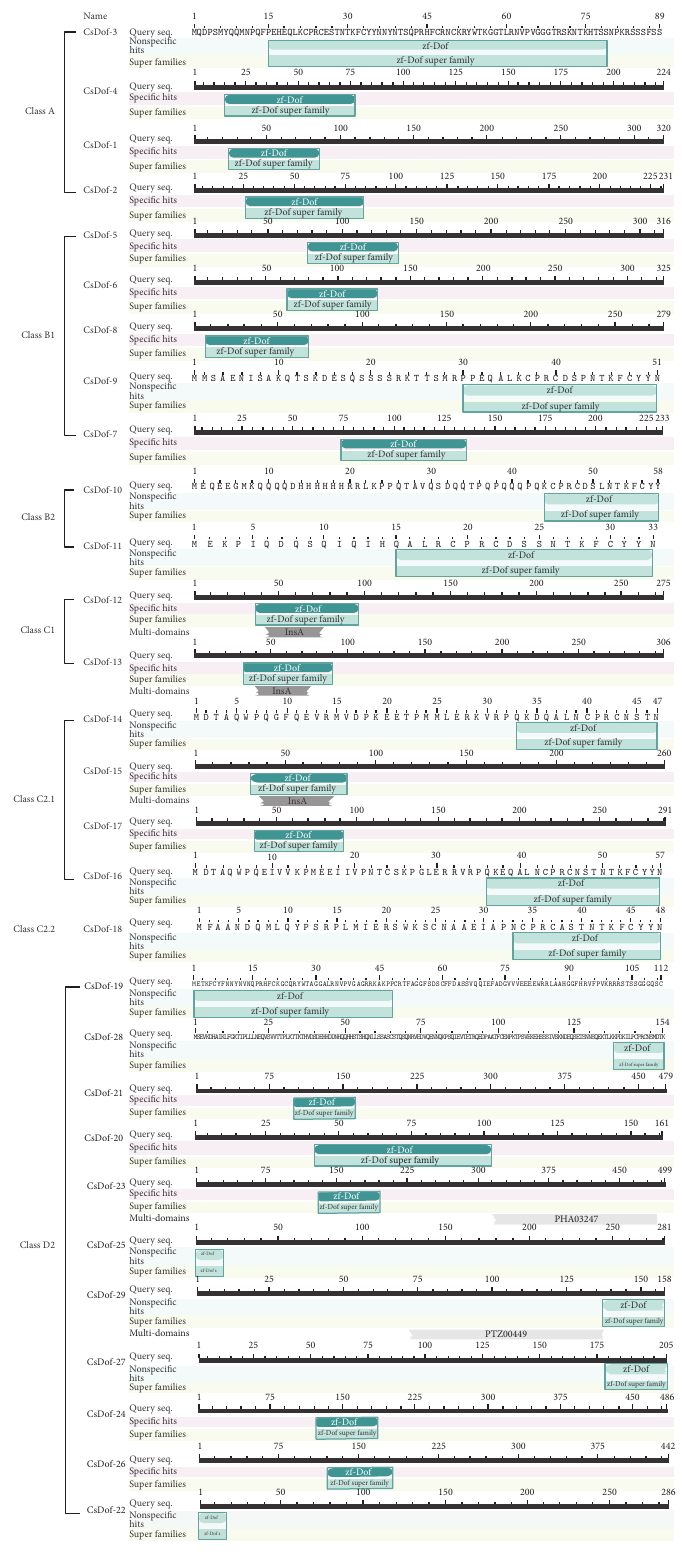
Figure 3: Conserved domains of CsDofs in C. sinensis